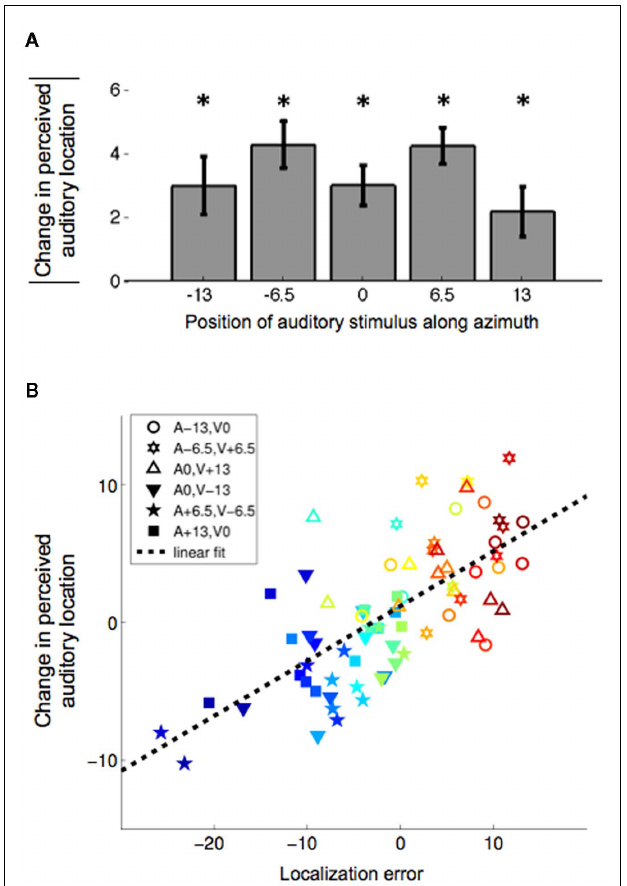
FIGURE 4 |The magnitude of the observed adaptation effect. (A) Mean localization aftereffect magnitude at each tested location. Aftereffect magnitudes are measured as the difference post-adaptation minus pre-adaptation in mean subject auditory responses ( N = 24). Here, positive aftereffects are defined as shifts in the direction of the visual stimulus offset presented during adaptation. * p < 0.05 two-tailed paired t -test, df = 23, Bonferroni corrected. (B) Scatter plot of aftereffect magnitude vs. pre-adaptation localization error. Aftereffects were measured as the post-adaptation minus pre-adaptation difference in the subjects’ mean auditory responses. Localization error was calculated at all bisensory pre-adaptation test locations with the same discrepancy ( ± 13˚) as that during exposure (3 data points per subjects × 24 subjects = 72 data points). The stimulus conditions are shown in the legend.The data points corresponding to theVA-adaptation and AV-adaptation groups are represented with filled and open symbols, respectively.The data points derived from the same subject share the same color. Dashed line shows a significant linear correlation of the data ( r = 0.70, p <